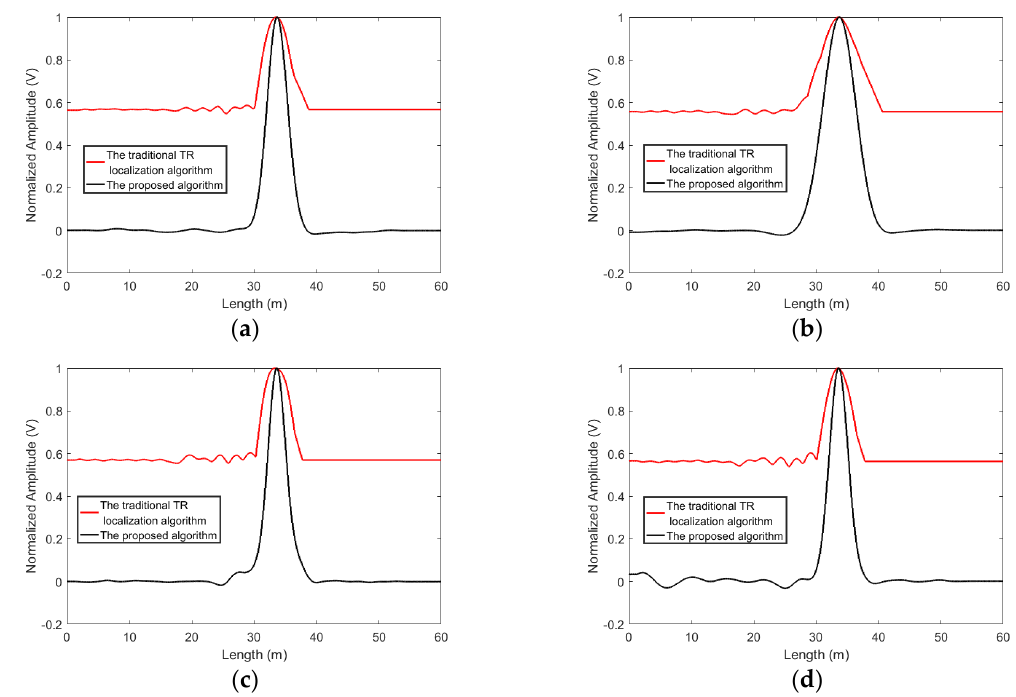
Figure 6. The four extra experiment results obtained by using the proposed algorithm and the traditional time reversal localization algorithm for Leakage 2. ( a ) Data 1, ( b ) Data 2, ( c ) Data 3, ( d ) Data 4.